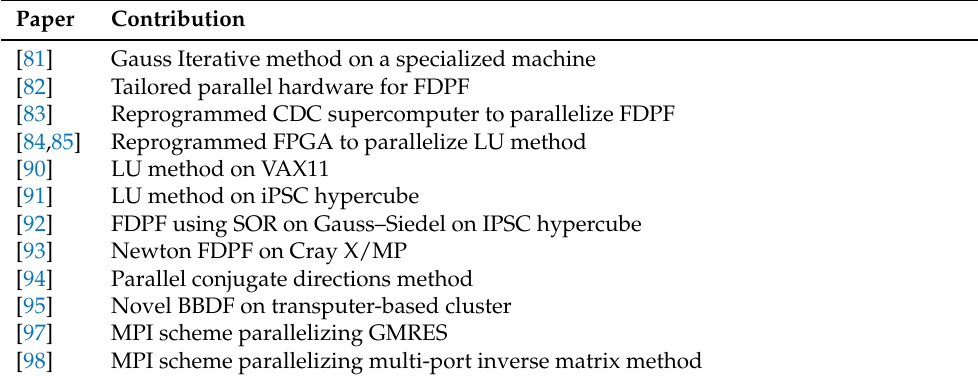
Table 2. Power flow MIMD-based state-of-the-art studies.